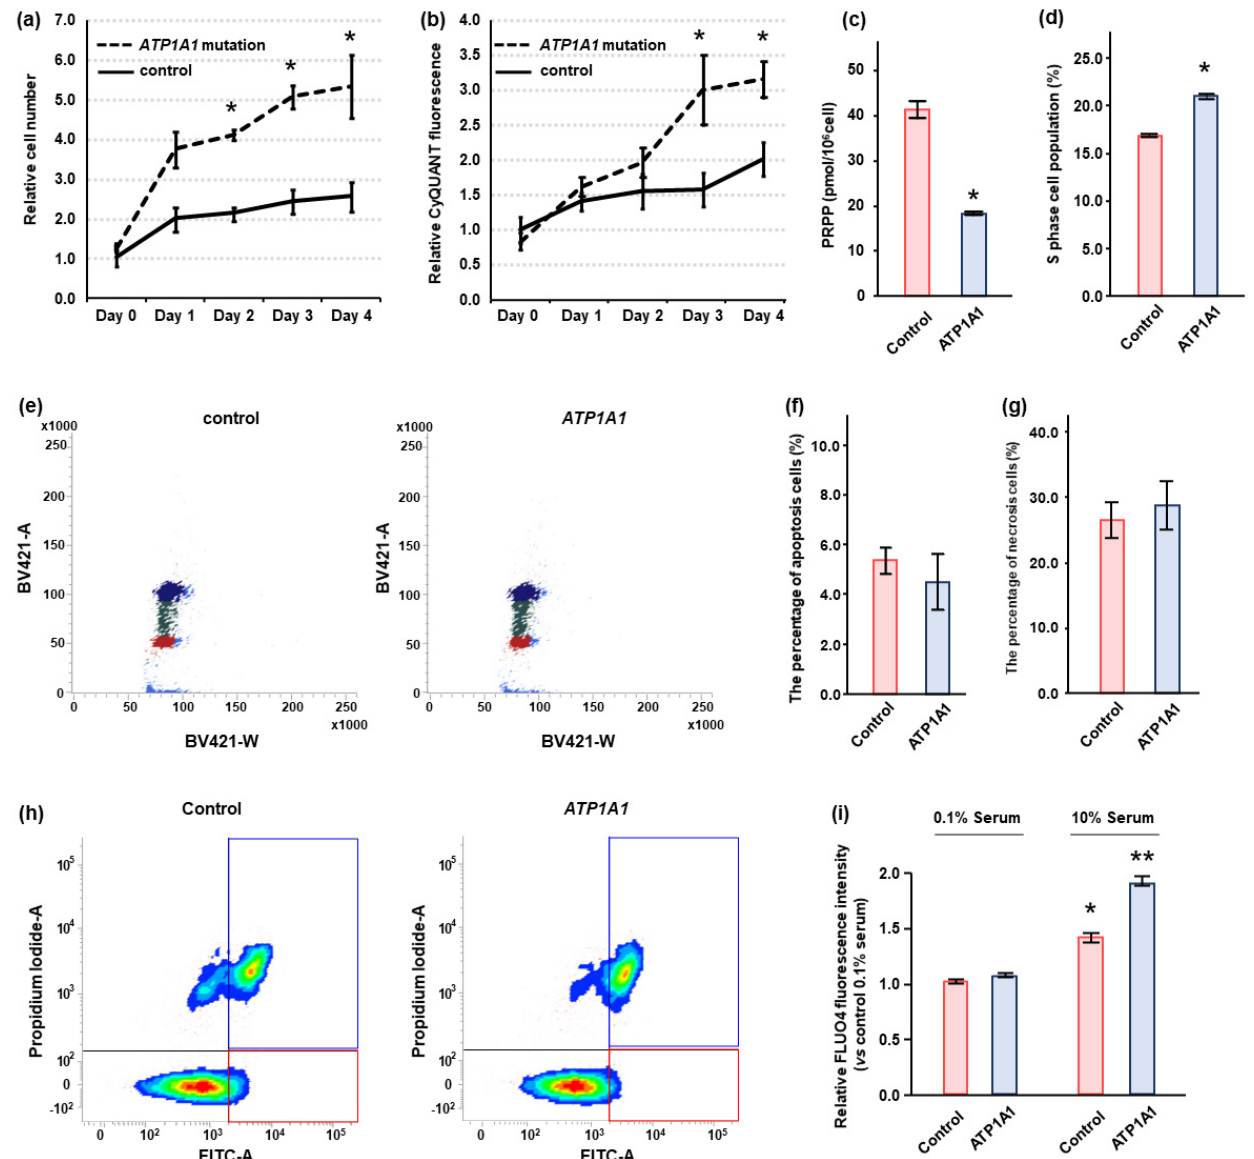
Figure 4. Effect of ATP1A1 L104R mutation on cell proliferation in HAC15 cells. ( a , b ) HAC15 cells with 40–50% confluency on 96-well plates were transduced with a lentivirus ATP1A1 mutant ( n = 6) or control ( n = 6) vectors. The cells were cultured in DMEM/F12 containing 10% serum. The effects of the ATP1A1 mutant on cell proliferation and DNA amounts were evaluated by counting cell number using TC20 Cell Counter at the indicated times and CyQUANT Direct Cell Proliferation Assay Kit, respectively. *, p < 0.05 vs. each type of control cells. ( c ) After transduction of ATP1A1 mutant ( n = 3) or control ( n = 3) in HAC15 cells and attainment of confluency. Cells were incubated in DMEM/F12 containing 10% serum on 6-well plates for 24 h, and Phosphoribosyl Diphosphate (PRPP) levels in cells were measured by capillary electrophoresis time-of-flight mass spectrometry. ( d , e ) After transduction of ATP1A1 mutant ( n = 3) or control ( n = 3) in HAC15 cells and attainment of confluency. Incubation with DMEM-F12 containing 10% cosmic calf serum on 6-well plates for 48 h, cells were treated with 10 μ M of cycloheximide for 24 h. The cells with supplemental solutions of Cell Cycle Assay Solution Blue were injected into the flow cytometer instrument, and the cells of G0/G1, S, or G2/M phase were shown in the figure with red, green, or blue, respectively. The number of cells of S phase were compared. *, p < 0.05 vs. control cells. ( f – h ) After transduction of ATP1A1 mutant ( n = 3) or control ( n = 3) and incubation with DMEM-F12 containing 10% cosmic calf serum on 6-well plates for 72 h, cells were harvested. Following Promokine Apoptotic/Necrotic Cells Detection kit (PromoCell, Heidelberg Germany), the cells (2.5 × 10 5 ) were incubated with Annexixn and Ethidium Homodimer for 15 m. The samples containing cells were injected into the flow cytometer instrument (BD FACSAriaIIu, BD Biosciences, Franklin Lakes, NJ). The results of control and ATP1A1 mutation are depicted in A and B, respectively. The cells in red and blue squares were